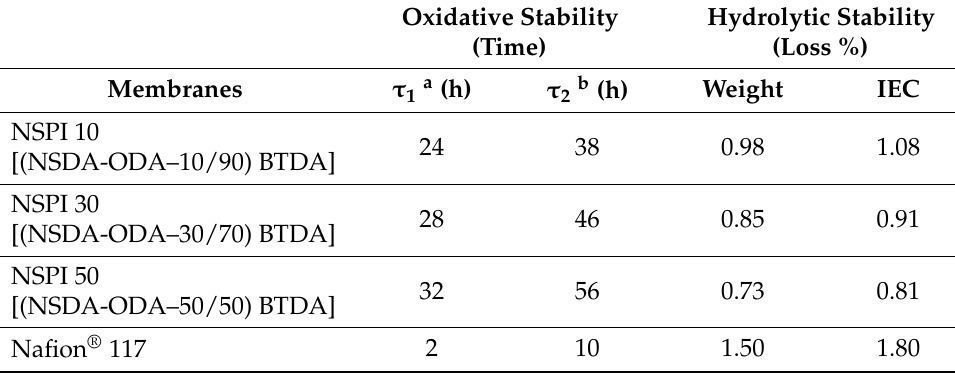
Table 2. Oxidative stability of NSPI membranes as measured by Fenton’s reagent. Oxidative Stability